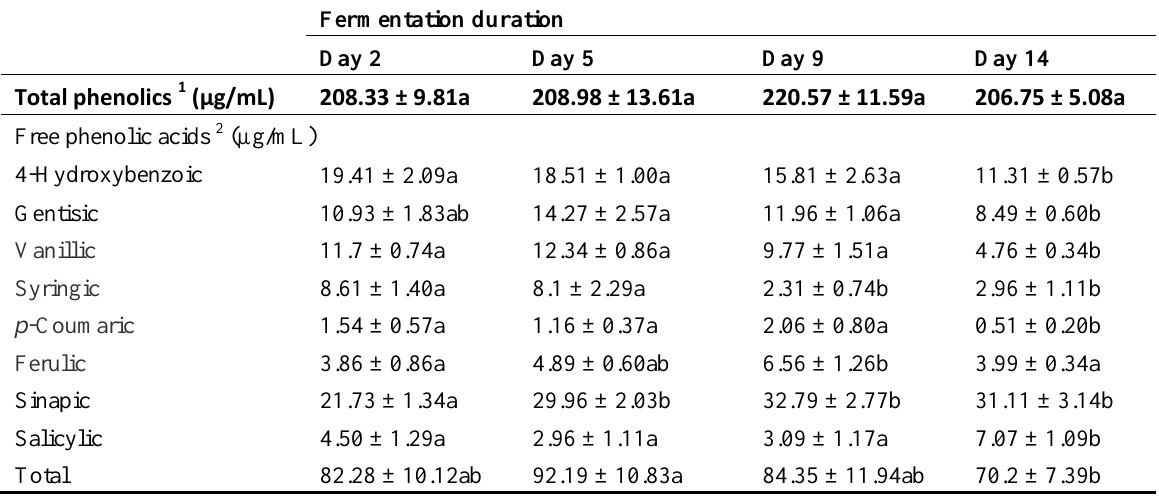
Table 4. Total phenolics and free phenolic acids in radish brines during